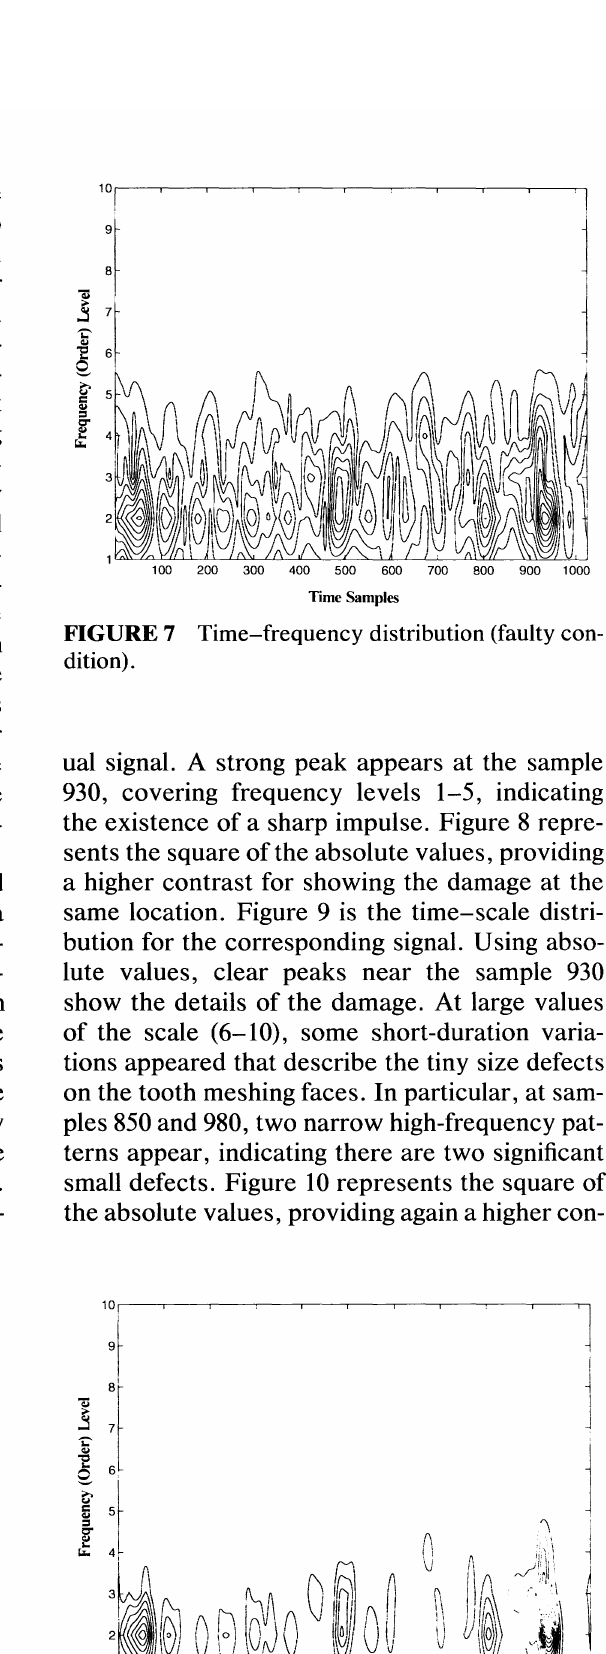
FIGURE 6 Synchronous averaged vibration and its residual.